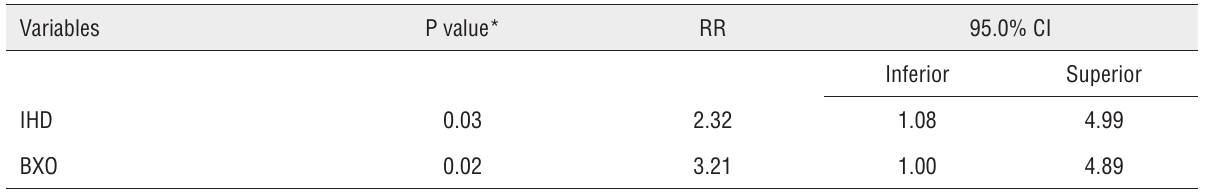
Table 2 - Odds Ratio (Binary regression).